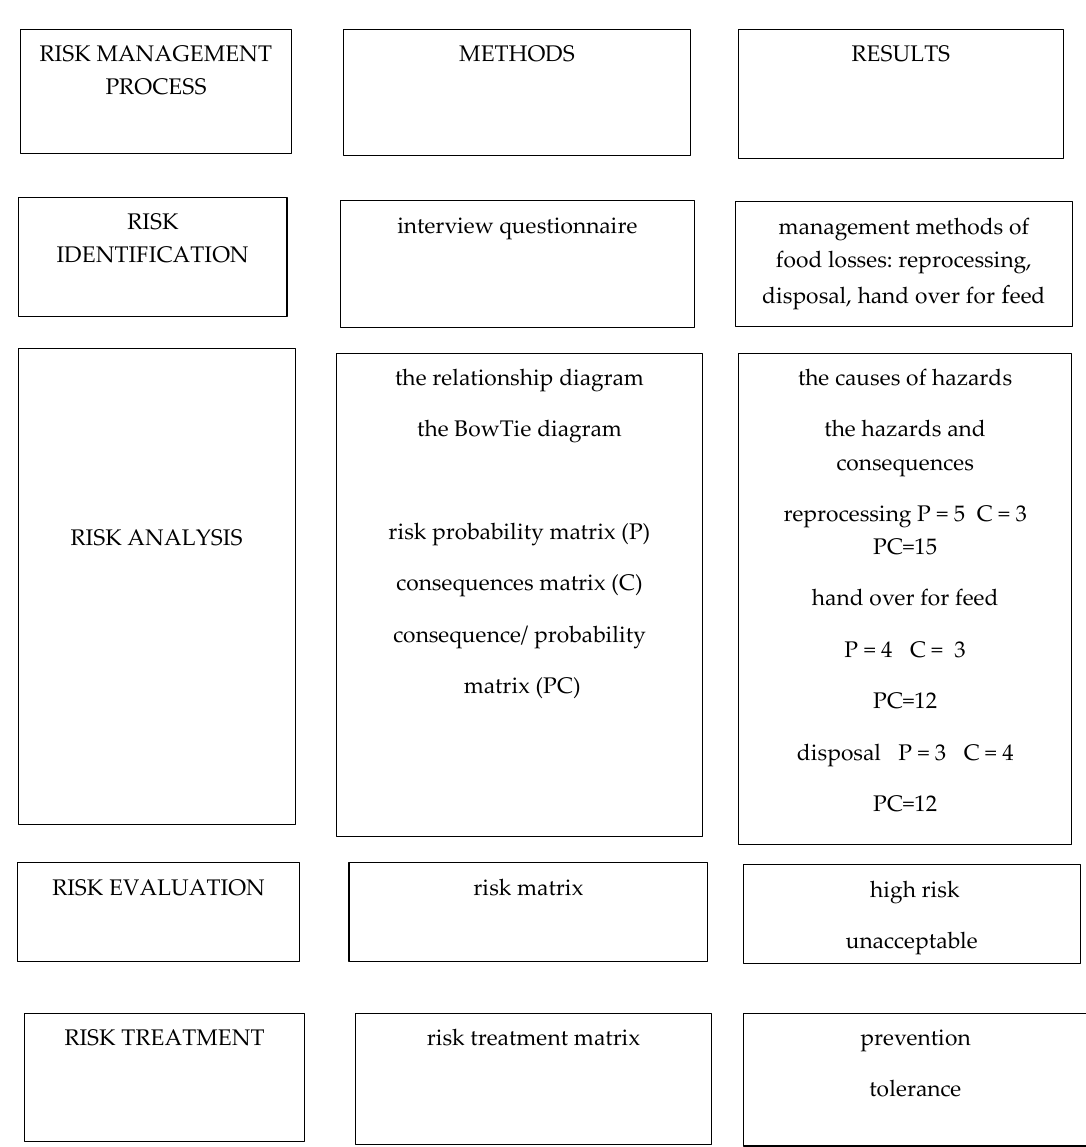
Figure 3. The risk management model for food loss: methods and results.